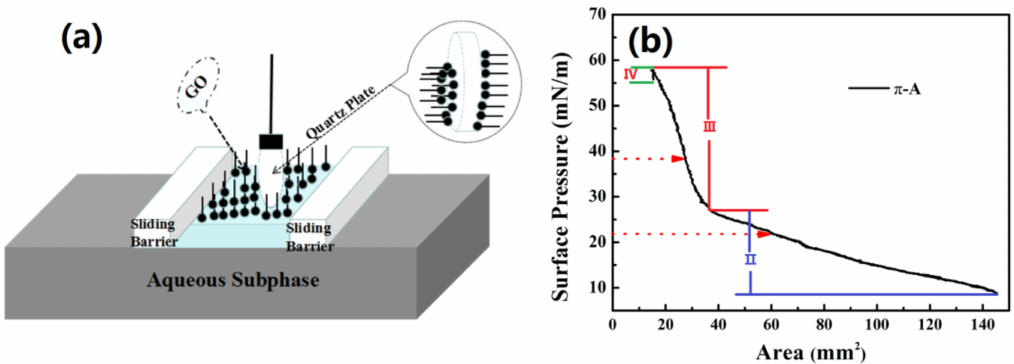
Figure 2. ( a ) Schematic of the Langmuir-Blodgett experimental setup; ( b ) surface pressure versus area ( π − A) isotherm of